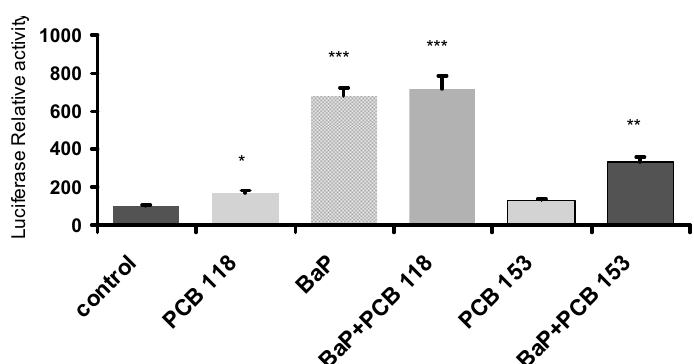
Figure 7. Effects of PCB118, PCB153 and BaP on AhR transcriptional activity. Following transfection with a luciferase reporter gene controlled by a xenobiotic esponsive element (XRE) sequence, cells were challenged with PCB118 (five micromolars) or PCB153 (five micromolars) in the presence or not of BaP (one micromolar) according to “Time 1” conditions reported under materials and methods. The values are represented as mean ± SD. n = 4 per group. The level of significance is given by comparison of treated trials with controls ( n = 4 per group): * p < 0.05, ** p < 0.01, *** p < 0.001.